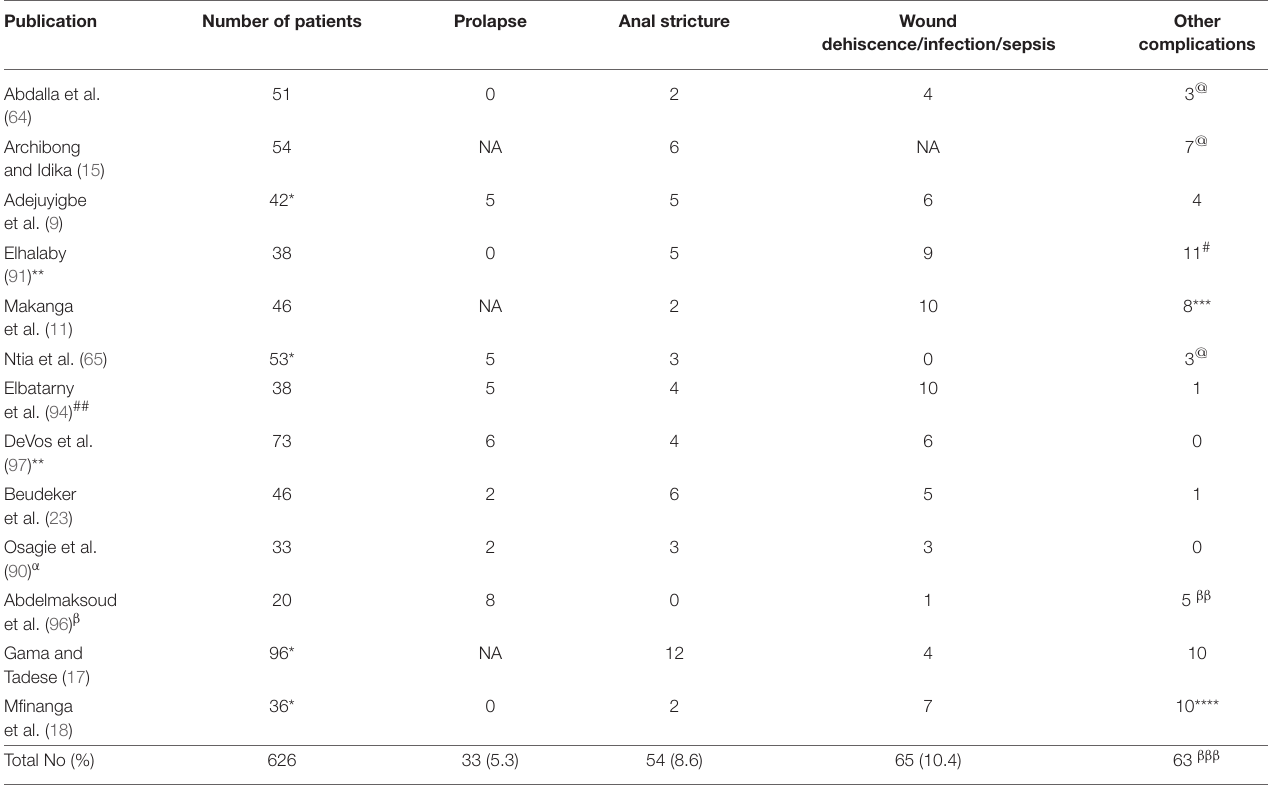
TABLE 3 | Complications following definitive surgery for patients with anorectal malformations in published series from